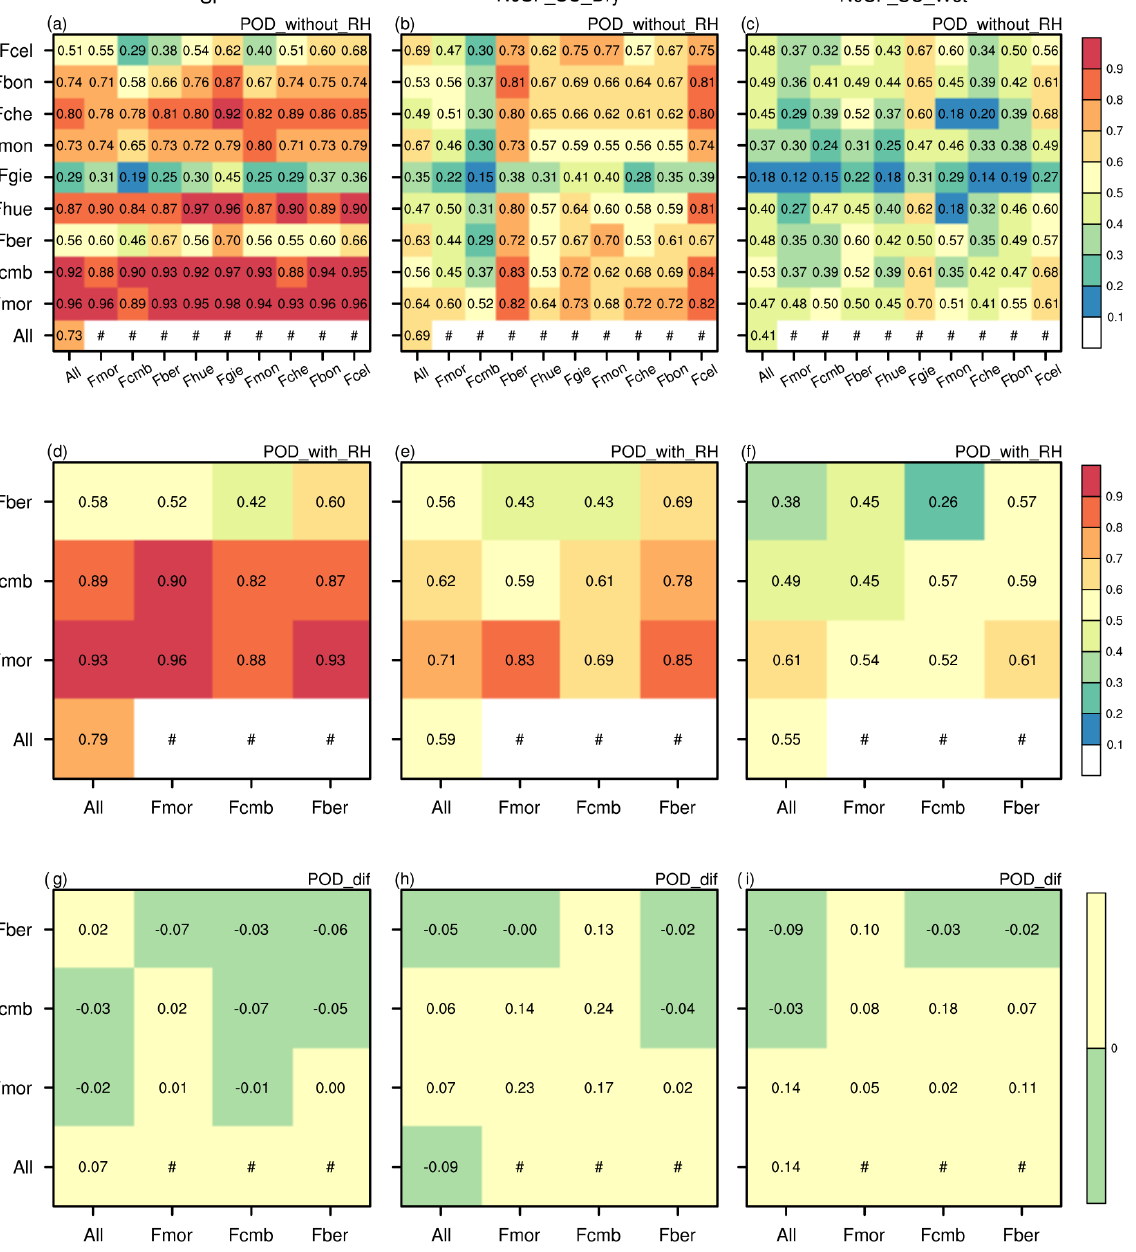
Figure 5. The same as Fig. 4 but for the probability of detection